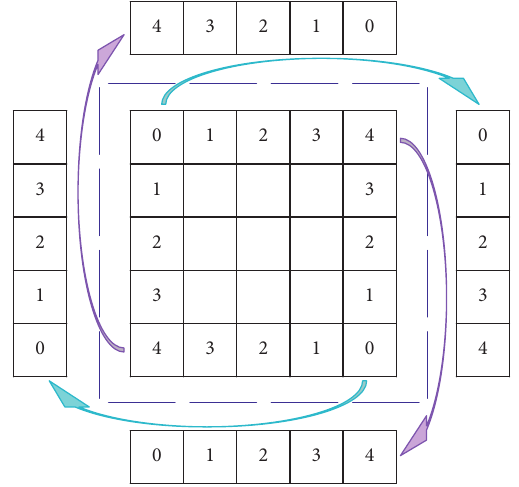
Figure 2: Schematic diagram of periodic boundary